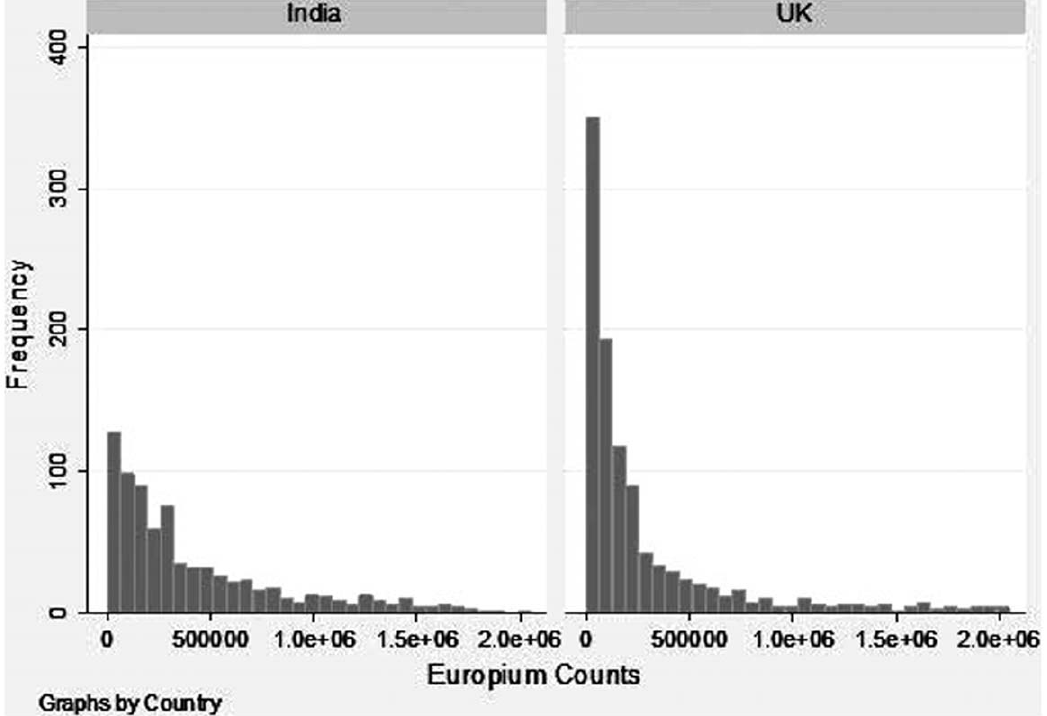
Figure 1. Distribution of Europium counts obtained with sera from the India and UK sera cohorts. The europium counts were log transformed for a normal distribution. The first plate from India was the reference category and a slope and intercept was calculated for all other plates from both India and the UK. The slope and the intercept values were used to standardize the log-transformed europium counts across experimental runs. Standardized log-transformed values were then used for all